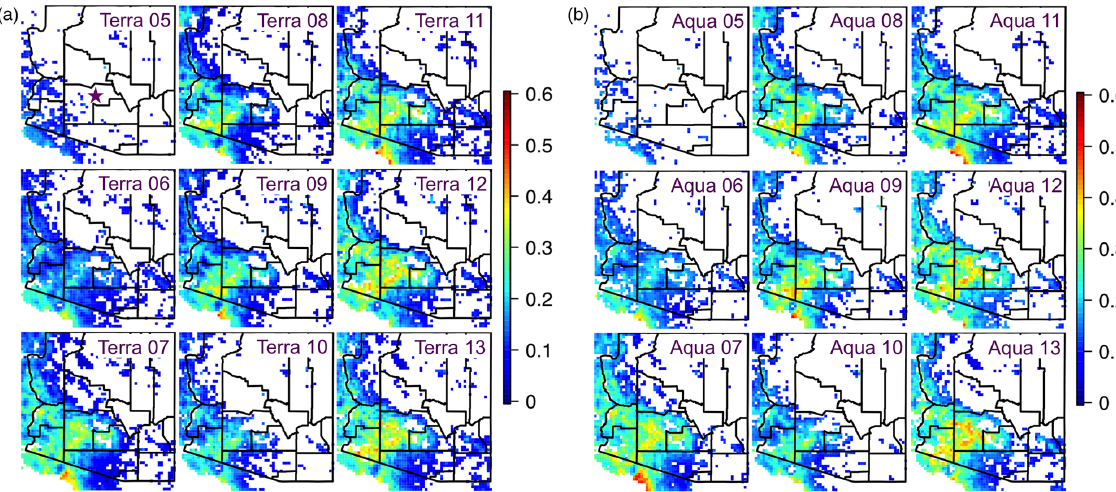
Figure 2. (a) DOD maps (in 0.1 ◦ × 0.1 ◦ horizontal resolution) in dust seasons from Terra MODIS during 2005–2013. Data are plotted only for the grids in which DOD data are available > 5% of the total number of days in each year (defined as “areas of dust impact”). The purple star in the upper left panel of (a) indicates the location of Phoenix. (b) Same as (a) , but for Aqua